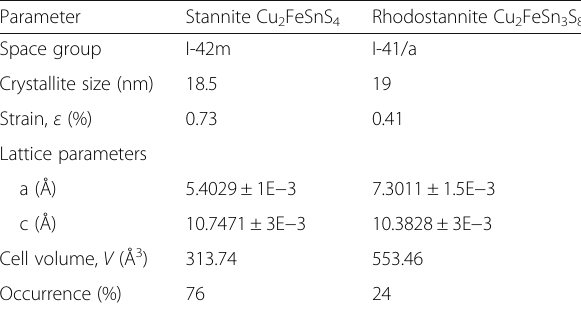
Table 1 Results obtained from Rietveld analysis of XRD data for the CFTS sample